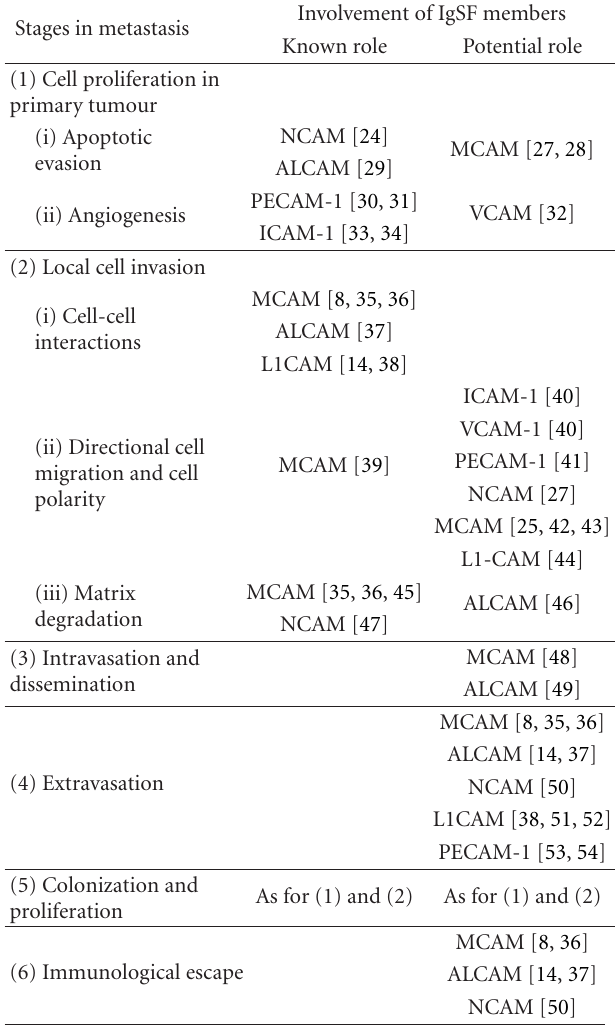
Table 1: The role of IgSF members in the metastatic